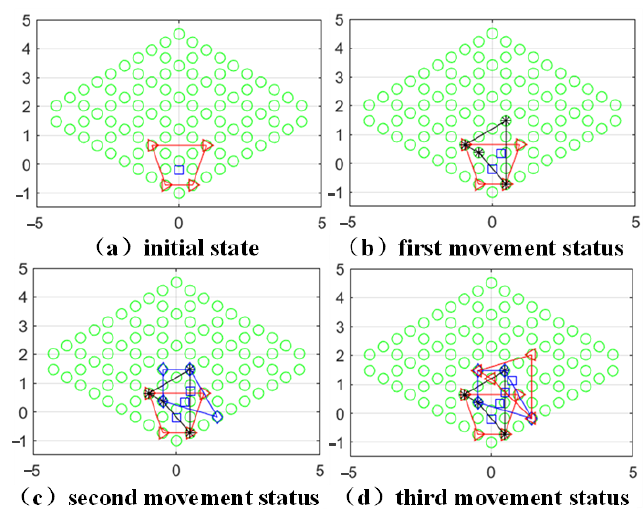
Figure 8. Trot gait planning motion